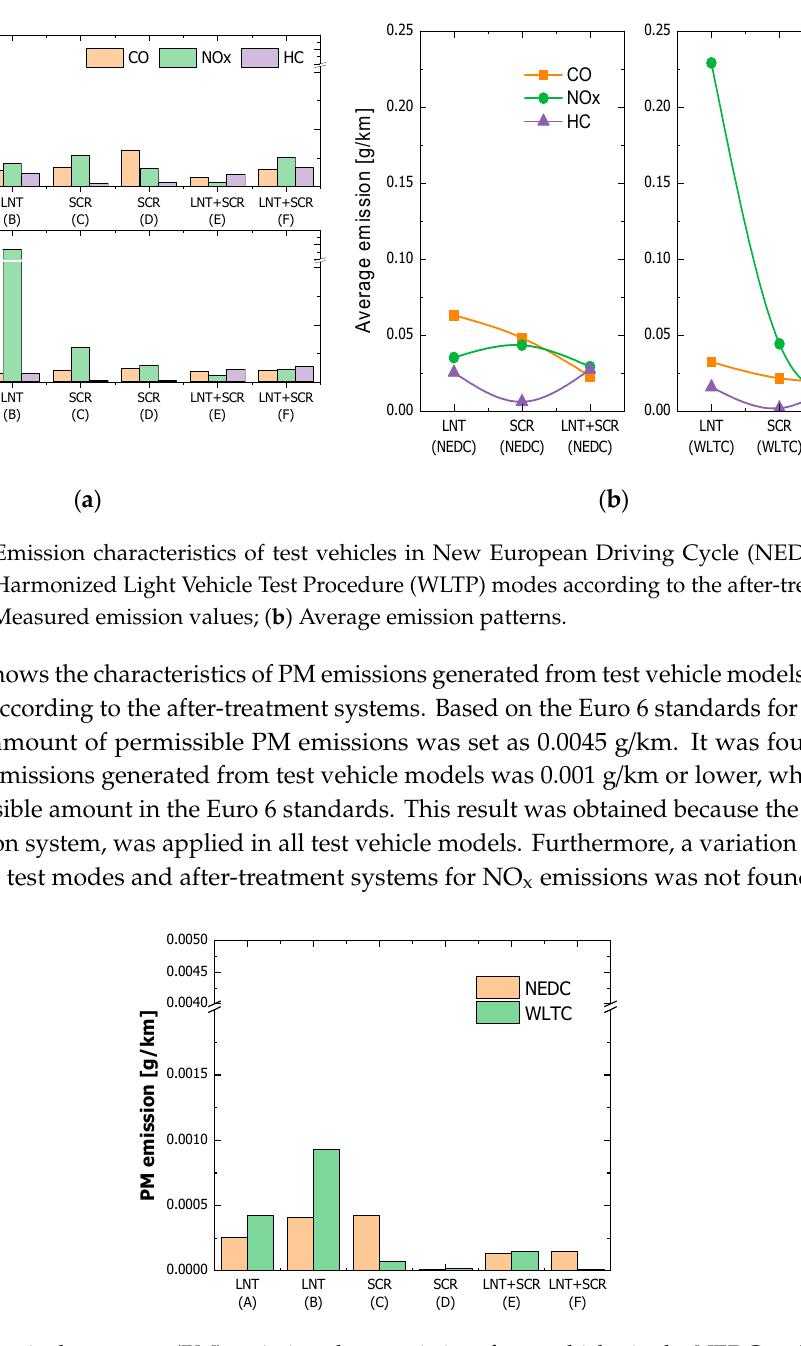
Figure 13. Particulate matter (PM) emission characteristics of test vehicles in the NEDC and WLTP modes according to the after-treatment system.